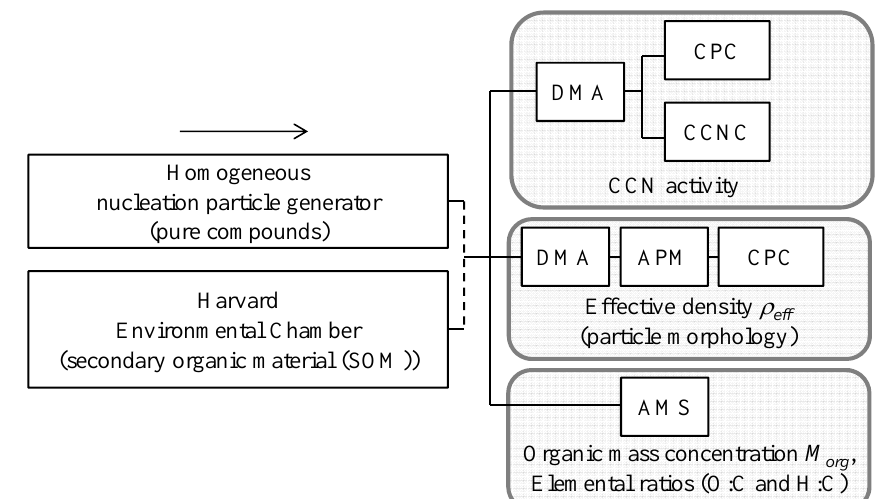
Fig. 2. Experimental setup. Abbreviations: TSI Differential Mobility Analyzer (DMA); TSI Condensation Particle Counter (CPC); DMT Cloud Condensation Nuclei Counter (CCNC); KANOMAX Aerosol Particle Mass Analyzer (APM); and Aerodyne Aerosol Mass Spectrometer